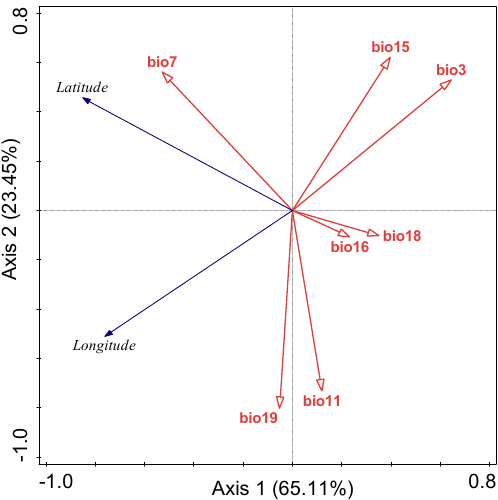
4 of 15 Figure 1. Vertical distribution patterns of the venerable trees in Sichuan in relation to: ( a ) tree abun- dance, and ( b ) species richness. The scatter points were fitted using a linear function.